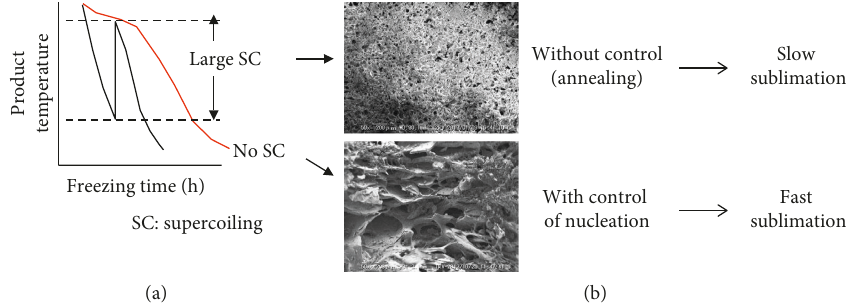
Figure 6: Schematic illustrations on controlled nucleation of ice [53]. (a) Time course of product temperature at a different freezing rate. (b) Scanning electron microscopy of lyophilized samples with and without control of nucleation of ice.